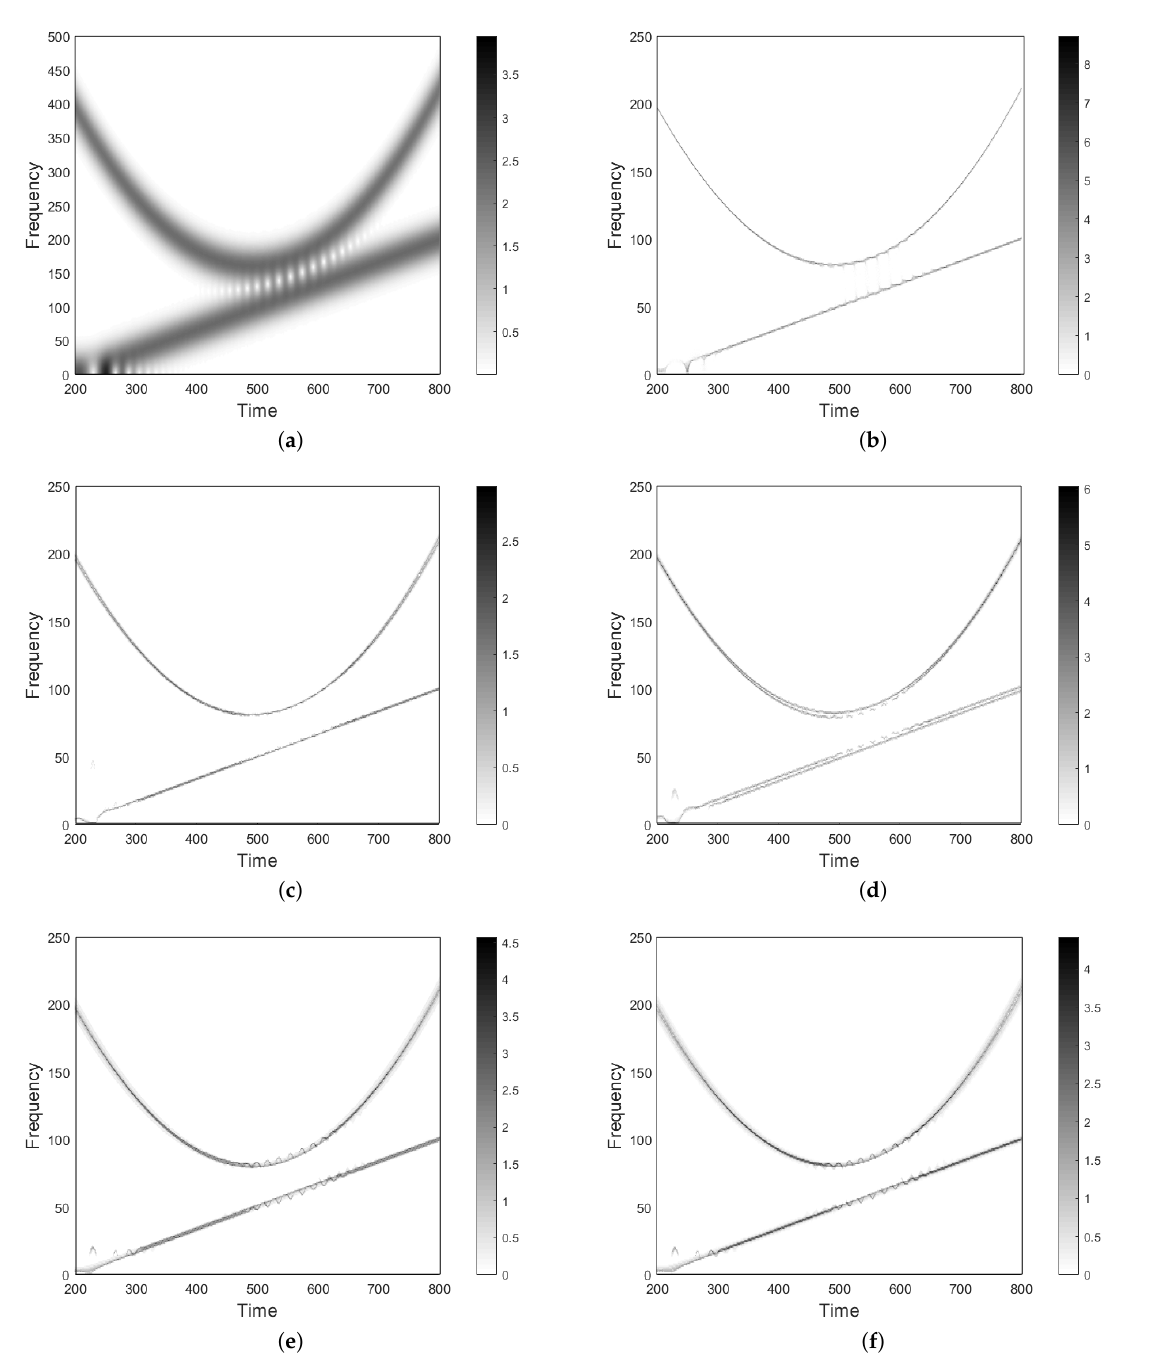
Figure 7. ( a ) Spectrogram of the two-component signal in Figure 1; ( b ) Standard reassigned spectrogram; ( c ) Reassigned spectrogram using 4 iterations of FIRST ; ( d ) Reassigned spectrogram using two iterations of FIRST ; ( e ) Reassigned spectrogram using one iteration of FIRST_K ; ( f ) Reassigned spectrogram using two iterations of FIRST_K with K = 1 − 1 √ . Reassignment results provided by the 2 proposed method are equivalent to the standard reassignment one since the separability condition is